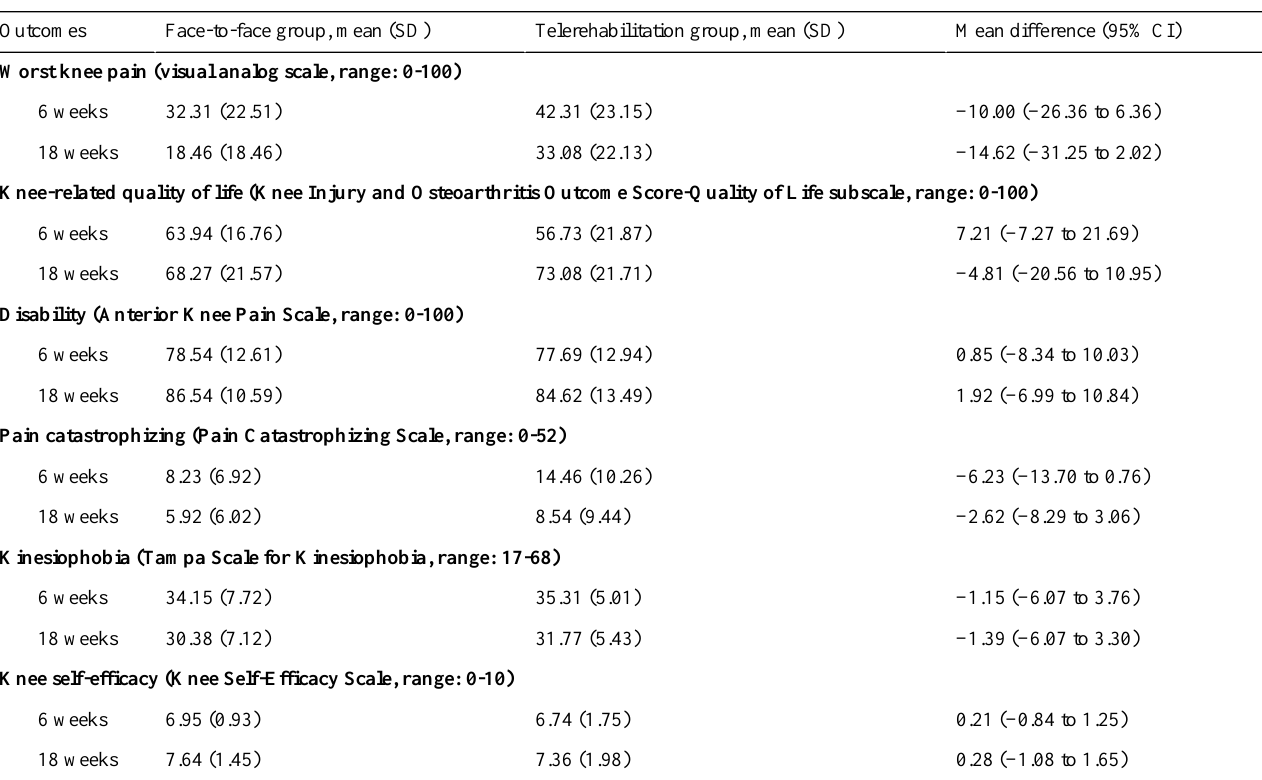
Table 3. Between-group comparisons for patient-reported outcomes at 6 and 18 weeks.